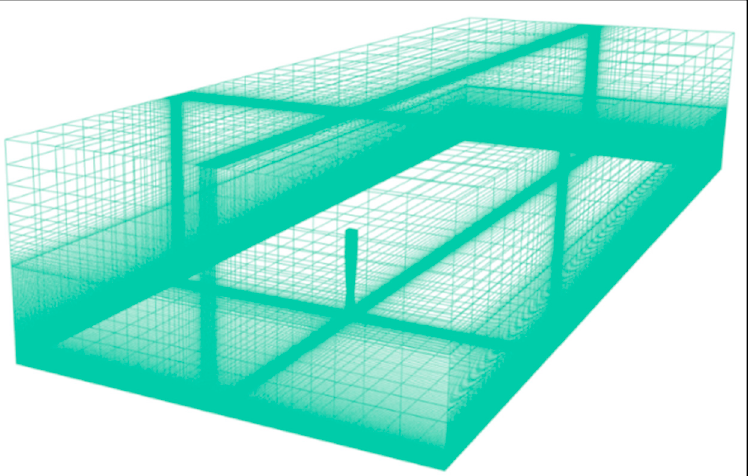
Figure 12. Virtual wind tunnel meshing.